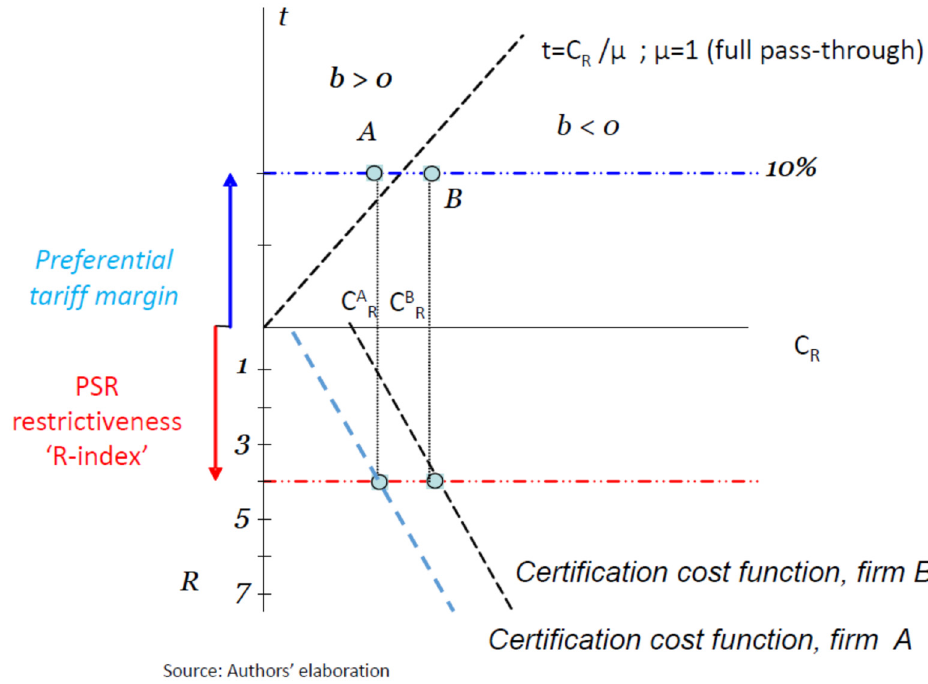
Figure 5. Different fixed certification costs and utilization of preferences.